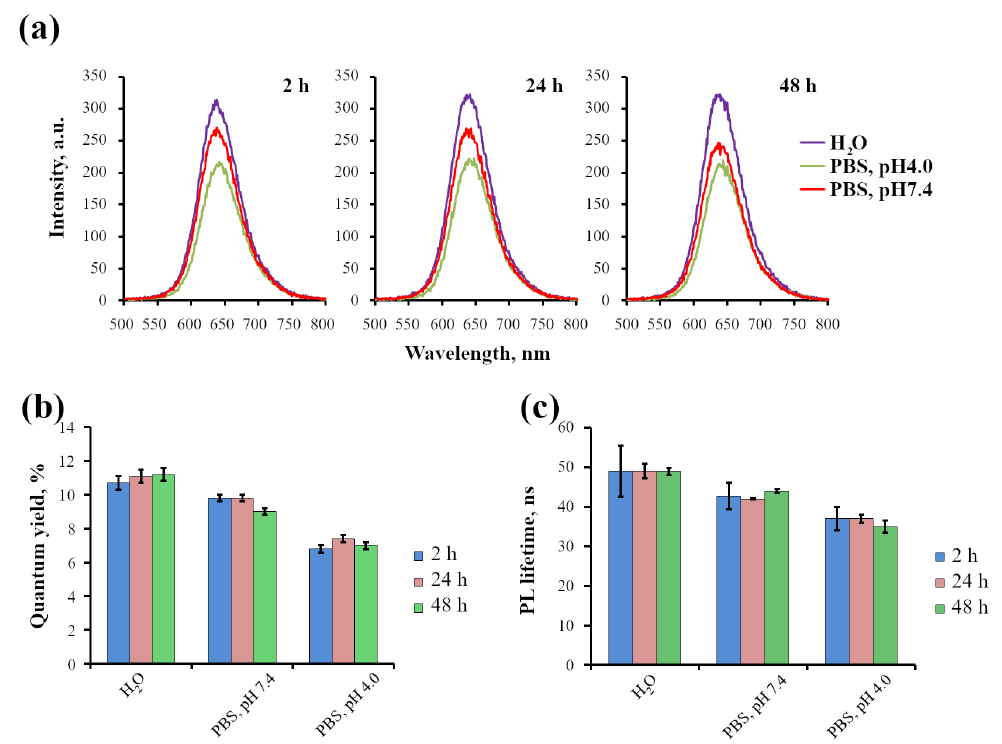
Figure 3. Effect of pH level on the photophysical characteristics of InP-QDs (80 nM). ( a ): Lumi- nescence spectra of InP-QDs in H 2 O and PBS solutions with different pH after 2, 24, and 48 h of incubation. ( b ): Quantum yields of InP-QD luminescence, %; ( c ): Lifetimes of InP-QD luminescence, ns. Data ( b , c ) represent the mean ± standard error of the mean from at least three independent